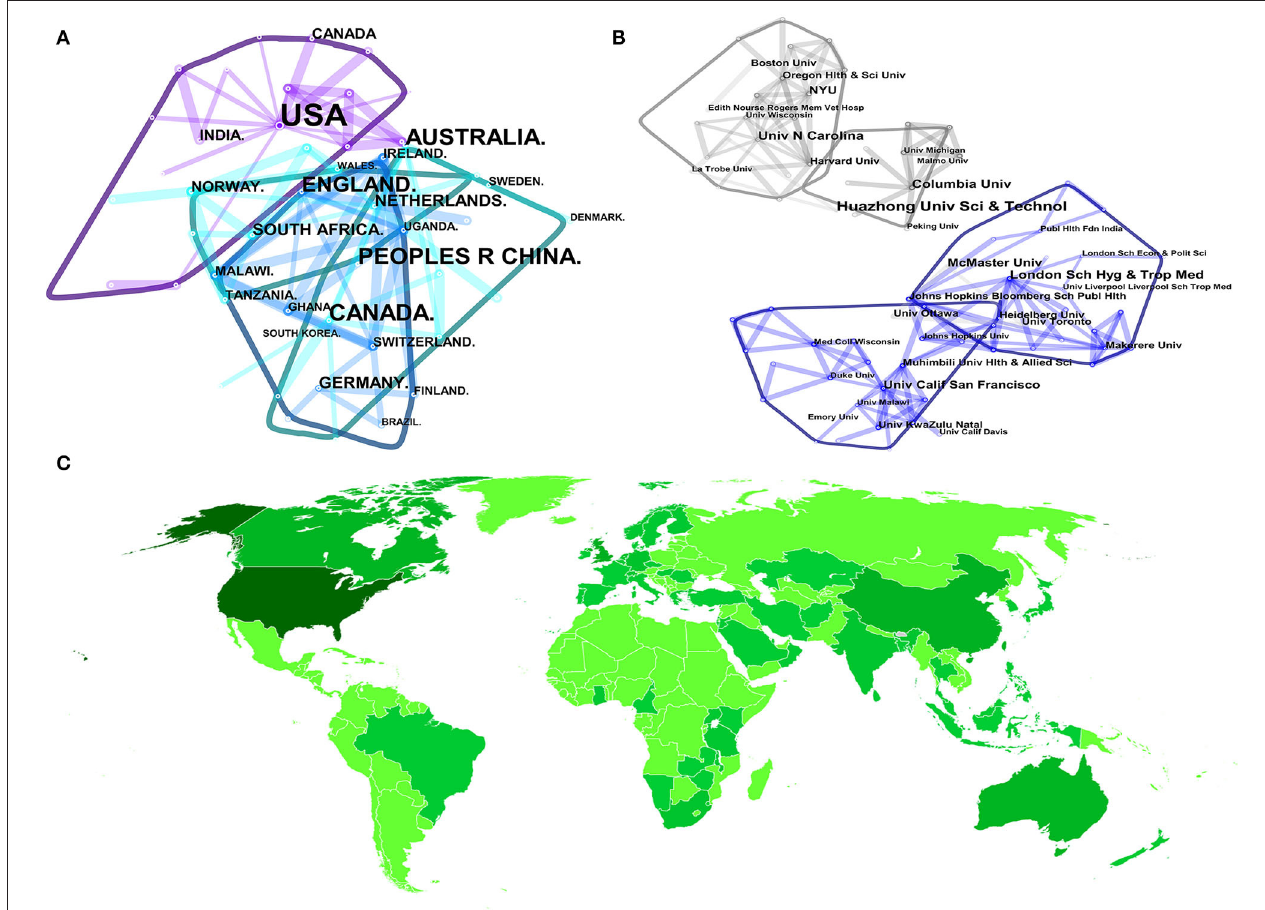
FIGURE 3 | Map of countries (A) , institutions (B) , and world distribution (C) of publications in the research field.